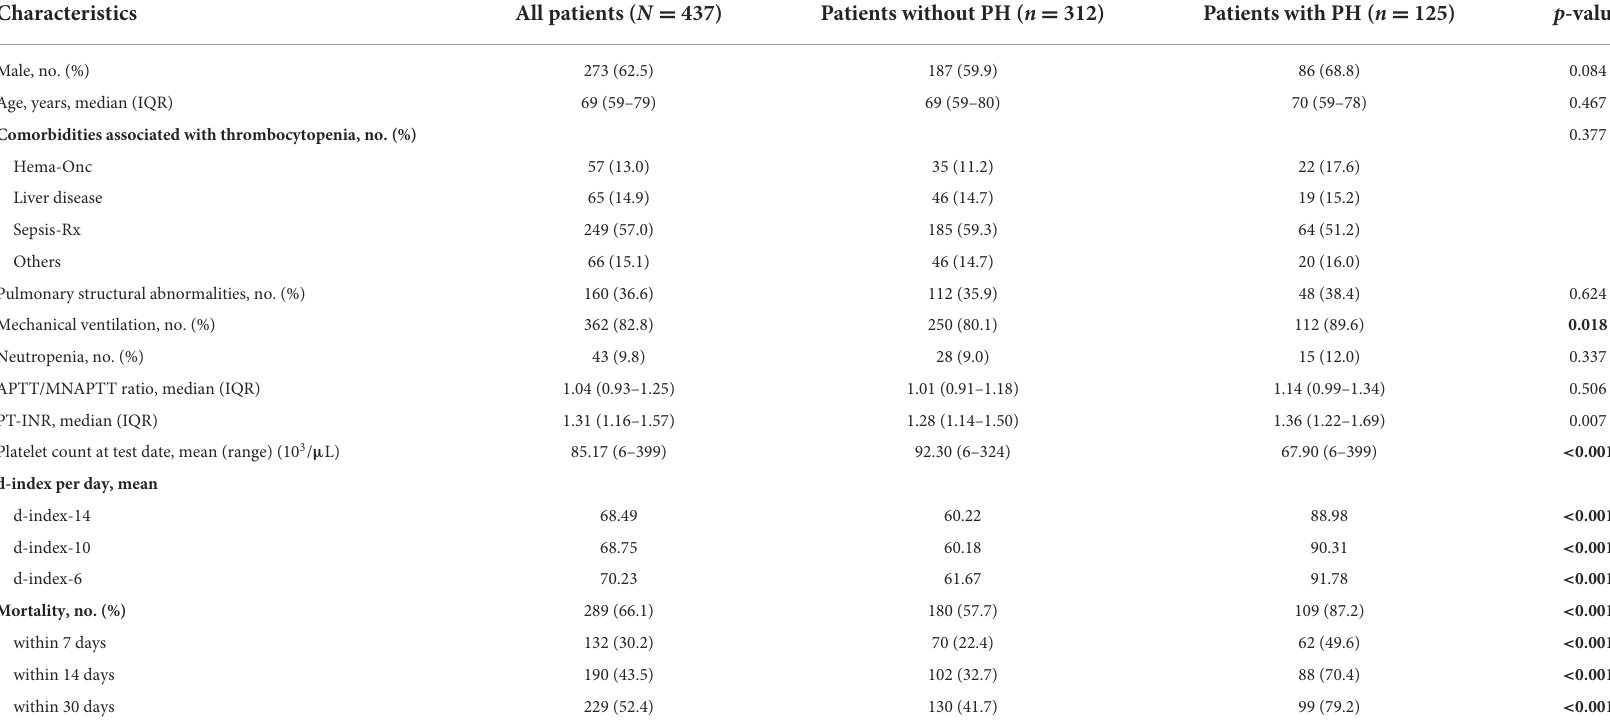
TABLE 1 Demographic and clinical characteristics of patients with SM respiratory